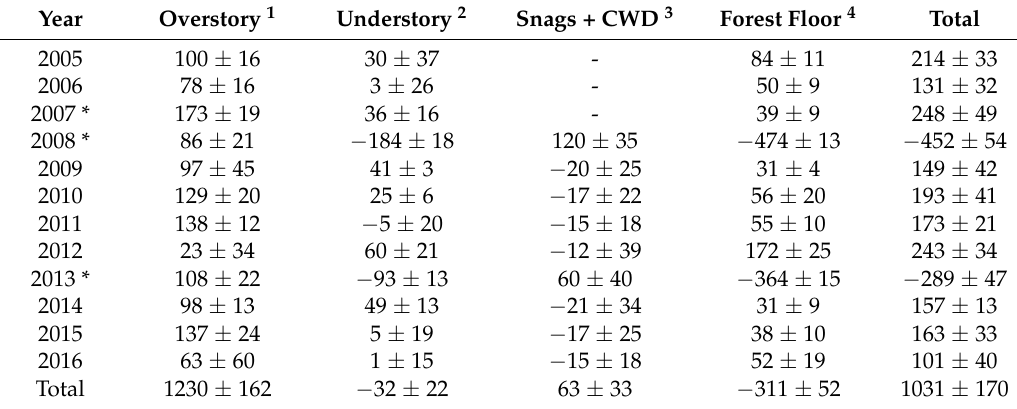
Table A5. Annual increment of woody stems of trees and saplings in the overstory, stem increment of understory shrubs and scrub oaks, net change of snags and coarse woody debris (CWD), and net accumulation of forest floor in tower plots at the pine stand from 2005 to 2016. All units